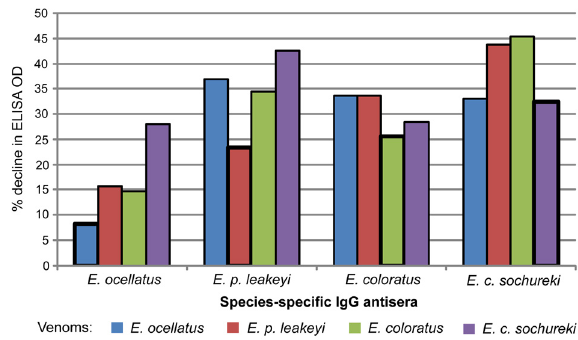
Figure 4. The Relative Avidity of each Echis species-specific IgG antisera to each Echis venom. Results are expressed as the percentage decline in ELISA optical density (405nm) from the control (incubation with 0 M ammonium thiocyanate) to the treatment (8 M). Boxed bars highlight homologous venom-antivenom results.